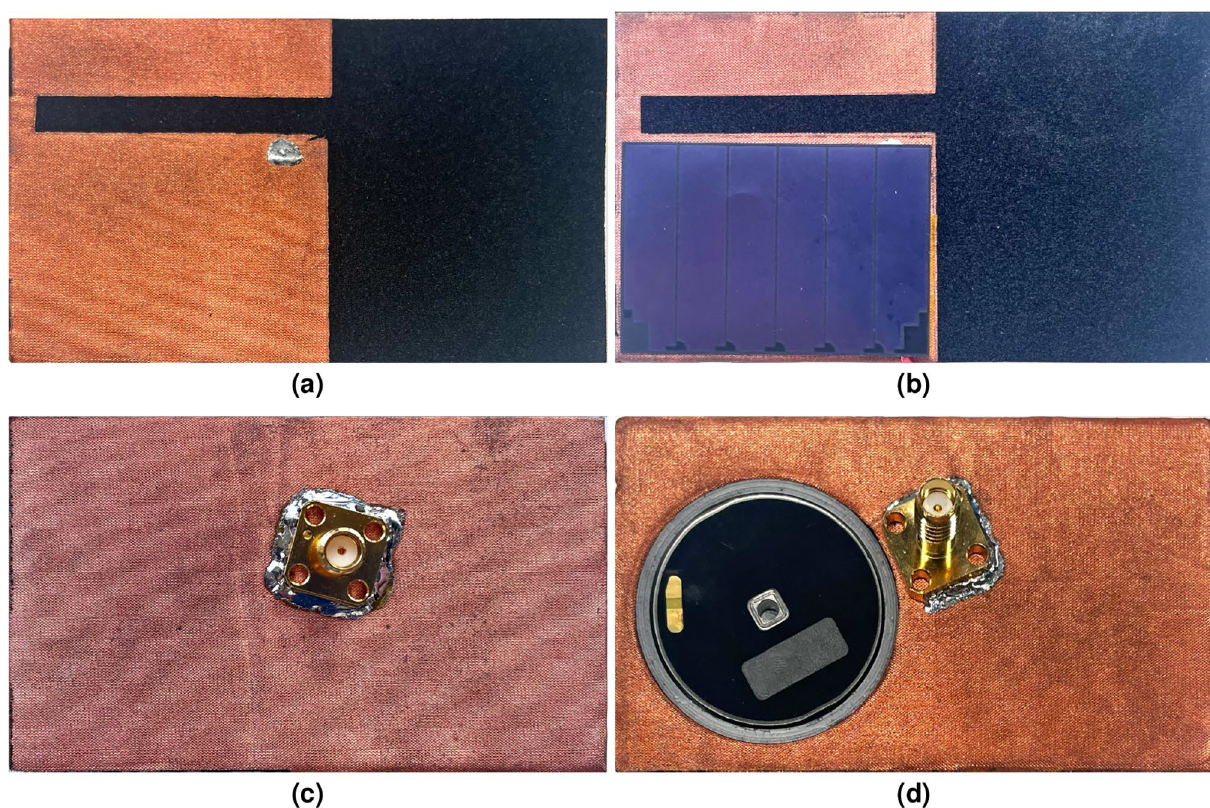
Figure 3. Fabricated antenna top view without photovoltaic cell (a) and with photovoltaic cell (b) , and bottom view without kinetic EH module (c) and with kinetic EH module (d) .